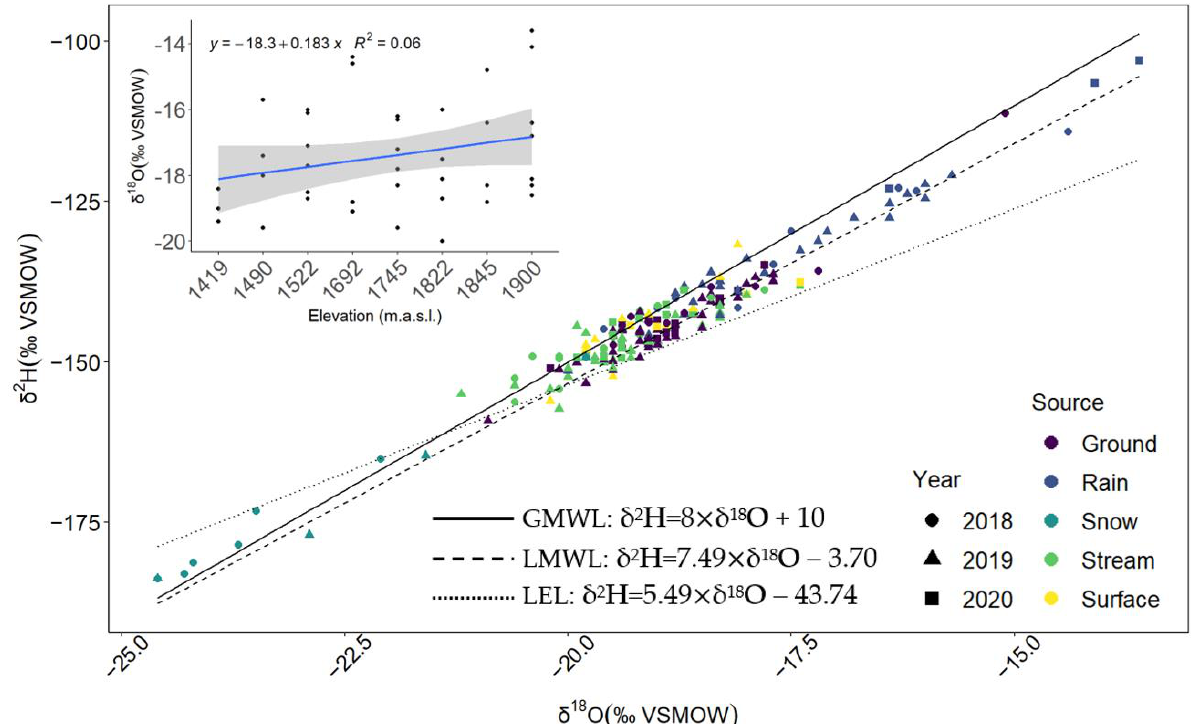
Figure 3. Dual isotope plot, with the source depicted by color, of grouped groundwater, rain, snow, stream, surface water samples collected at intensive sites in 2018, 2019, 2020 plotted along the GMWL. LMWL and LEL taken from Katvala et al. [40] for the Kananaskis Valley, Alberta, Canada. Inset figure is a plot of rain δ 18 O vs. elevation (increasing elevation from right to left) shown for all rain data. Samples from the subalpine wetland (In 1900) trended more towards the GMWL, de- spite having a lower slope, indicating greater influence of meteoric water sources (Figure